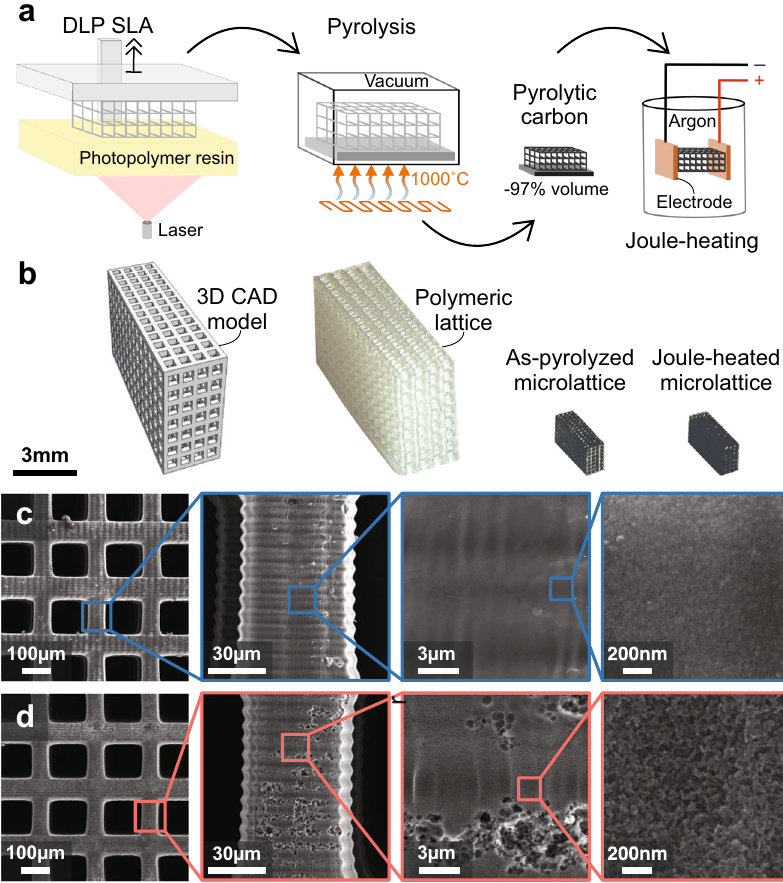
Fig. 1 Fabrication and SEM characterization of as-pyrolyzed and Joule-heated carbon microlattices. a Illustration of the manufacturing process that includes DLP SLA of cubic microarchitectures from photoresist resin, high-temperature pyrolysis up to 1000 °C under vacuum, and Joule heating in an argon environment. b Three-dimensional lattice CAD model and optical images of additively manufactured polymeric, pyrolytic carbon and Joule-heated carbon microarchitectures. SEM images of representative as-pyrolyzed ( c ) and Joule-heated ( d ) carbon microlattices, showing that the features introduced by 3D-fabrication are orientation-dependent strut width and micrometer groove pattern. Progressive magni fi cation reveals the smooth surfaces of the former and the porous morphology of the